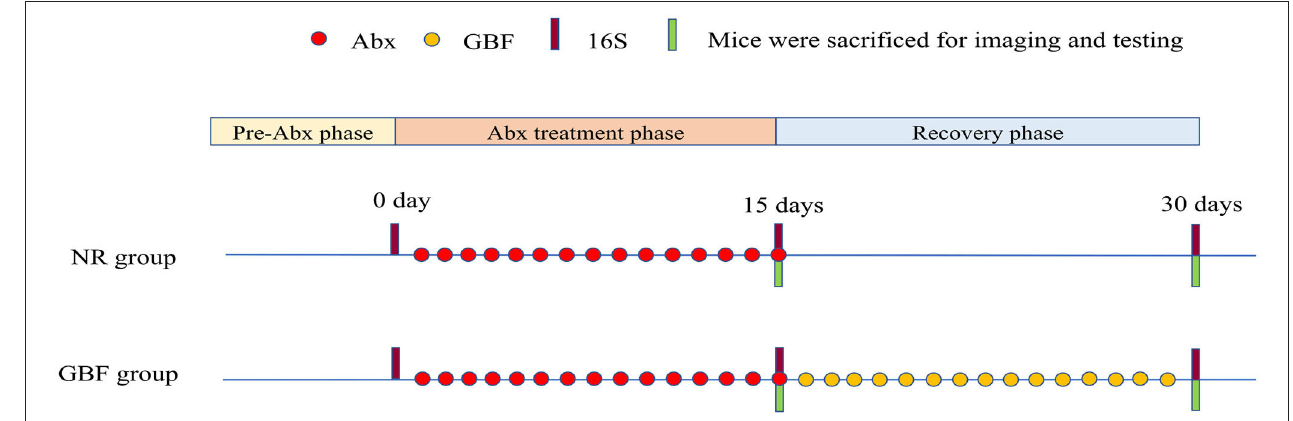
FIGURE 1 | Experimental scheme. After 1 week of acclimation, the mice were treated with Abx and recovered naturally or with GBF as shown in the scheme. 16S ribosomal DNA (rDNA) sequencing analysis of the feces was performed on the 0, 15, and 30th days. Abx, antibiotics; NR, natural recovery; GBF, green banana